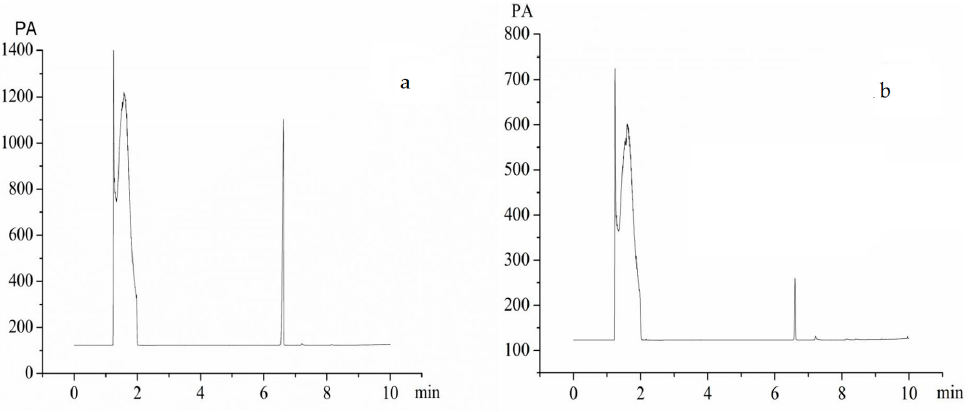
Figure 8. Gas chromatograms of samples ( a ) DMSO standard solution; and ( b ) vitexin processed by the ASP process.